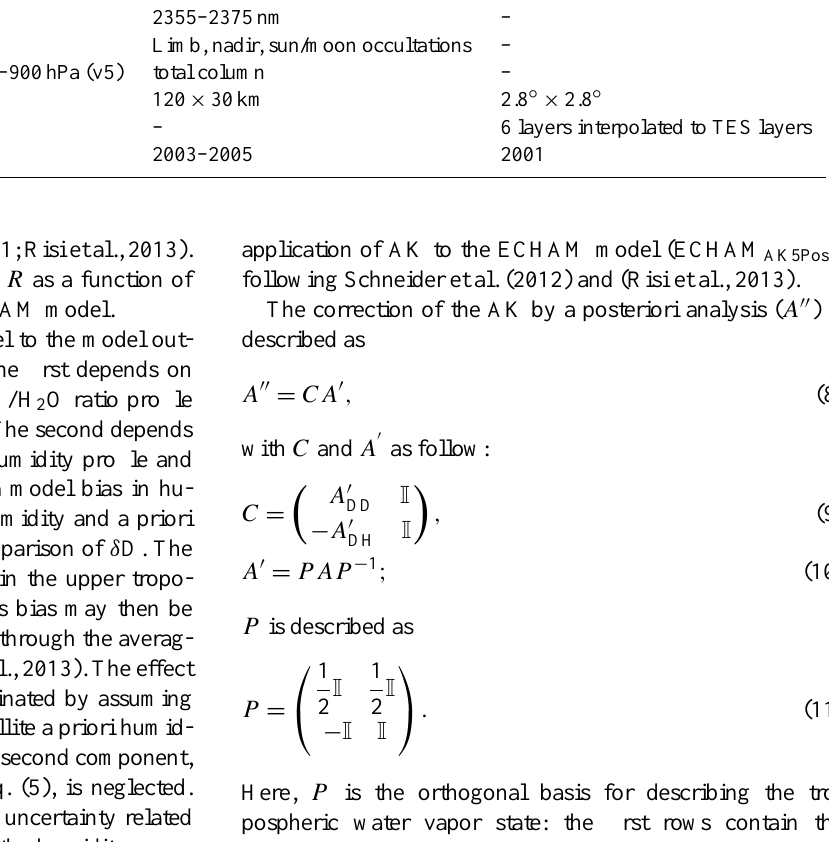
Table 1. Comparison of satellite instruments and the model used in this study. Comparison TES SCIAMACHY ECHAM Satellite Aura ENVISAT – Wavelength 650–3050cm − 1 2355–2375nm – Mode Limb, nadir Limb, nadir, sun/moon occultations – Sensitivity 500–850hPa (v4) and 425–900hPa (v5) total column